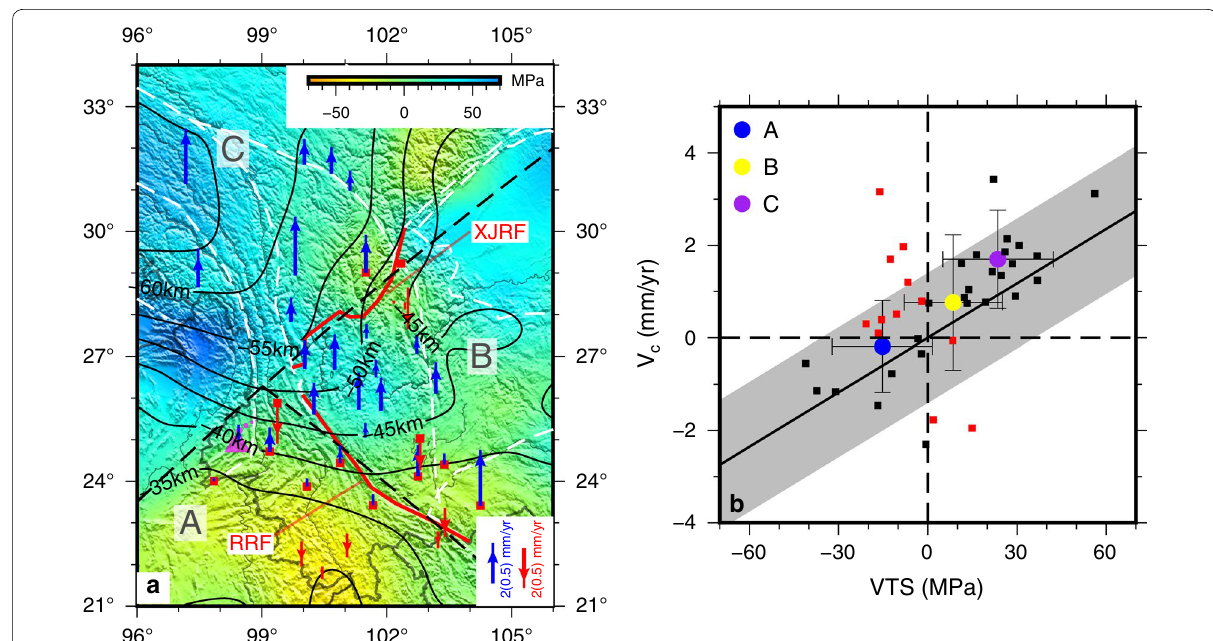
Fig. 4 VTSs and V c of the SYF. a The distribution of the VTSs and V c . The blue and red arrows denote up and down vertical rates V c deduced from three-dimension GPS rate field, respectively. The colors represent the VTSs. The black contour lines with numbers show the depth of Moho. The red squares denote the stations with inconsistent orientations between VTSs and V c . The meaning of the symbols and lines is same as Fig. 2. b Scatters of the VTS and V c . The black line crossing the origin is the linear fitting of the scatters, and the gray area denotes the standard deviation of the scatters. Vertical and horizontal dashed lines are the zero lines of the VTS and V c , respectively. The blue, yellow and purple dots denote the scatters of the averages of the three sections (A, B and C in Fig. 4a). The error bars denote the standard deviations in A, B and C